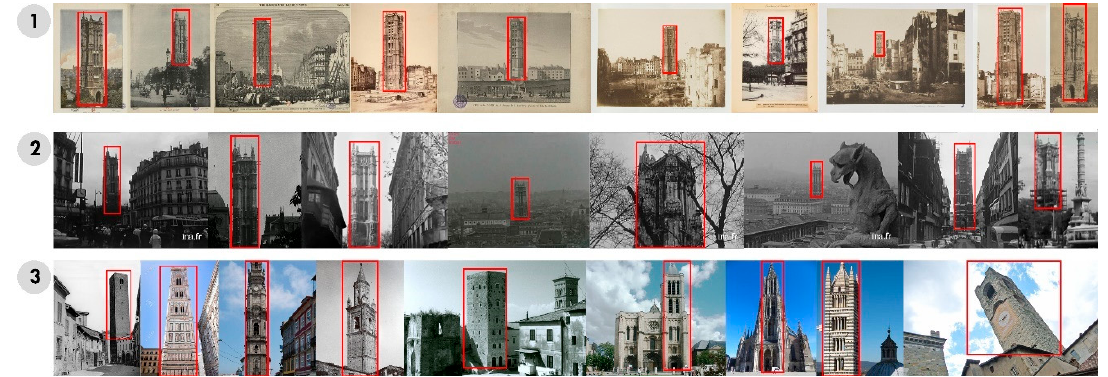
Figure 6. A selection of the pictures from the dataset 3 for the tower: ( 1 ) historical photographs; ( 2 ) historical images; ( 3 ) negative matching. Table 4. Description of the training and validation dataset 3 on the real case of the Tour Saint Jacques.